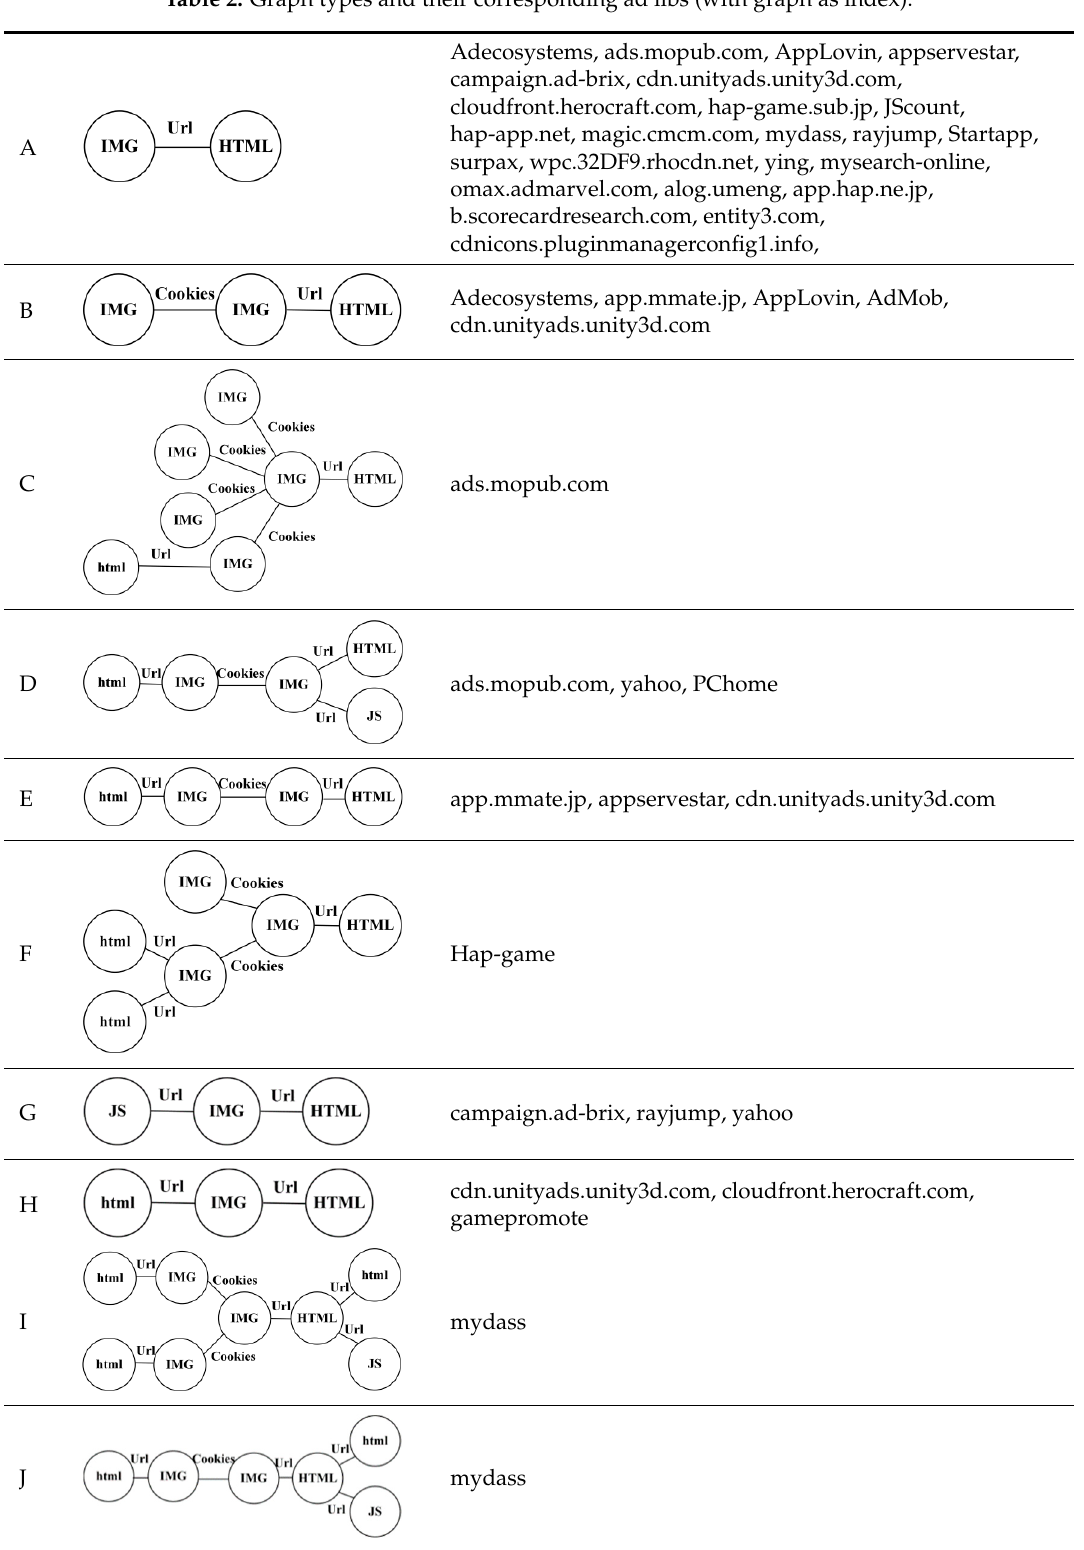
Table 1. Advertising behavior graphs of ad libs (with ad lib as index).